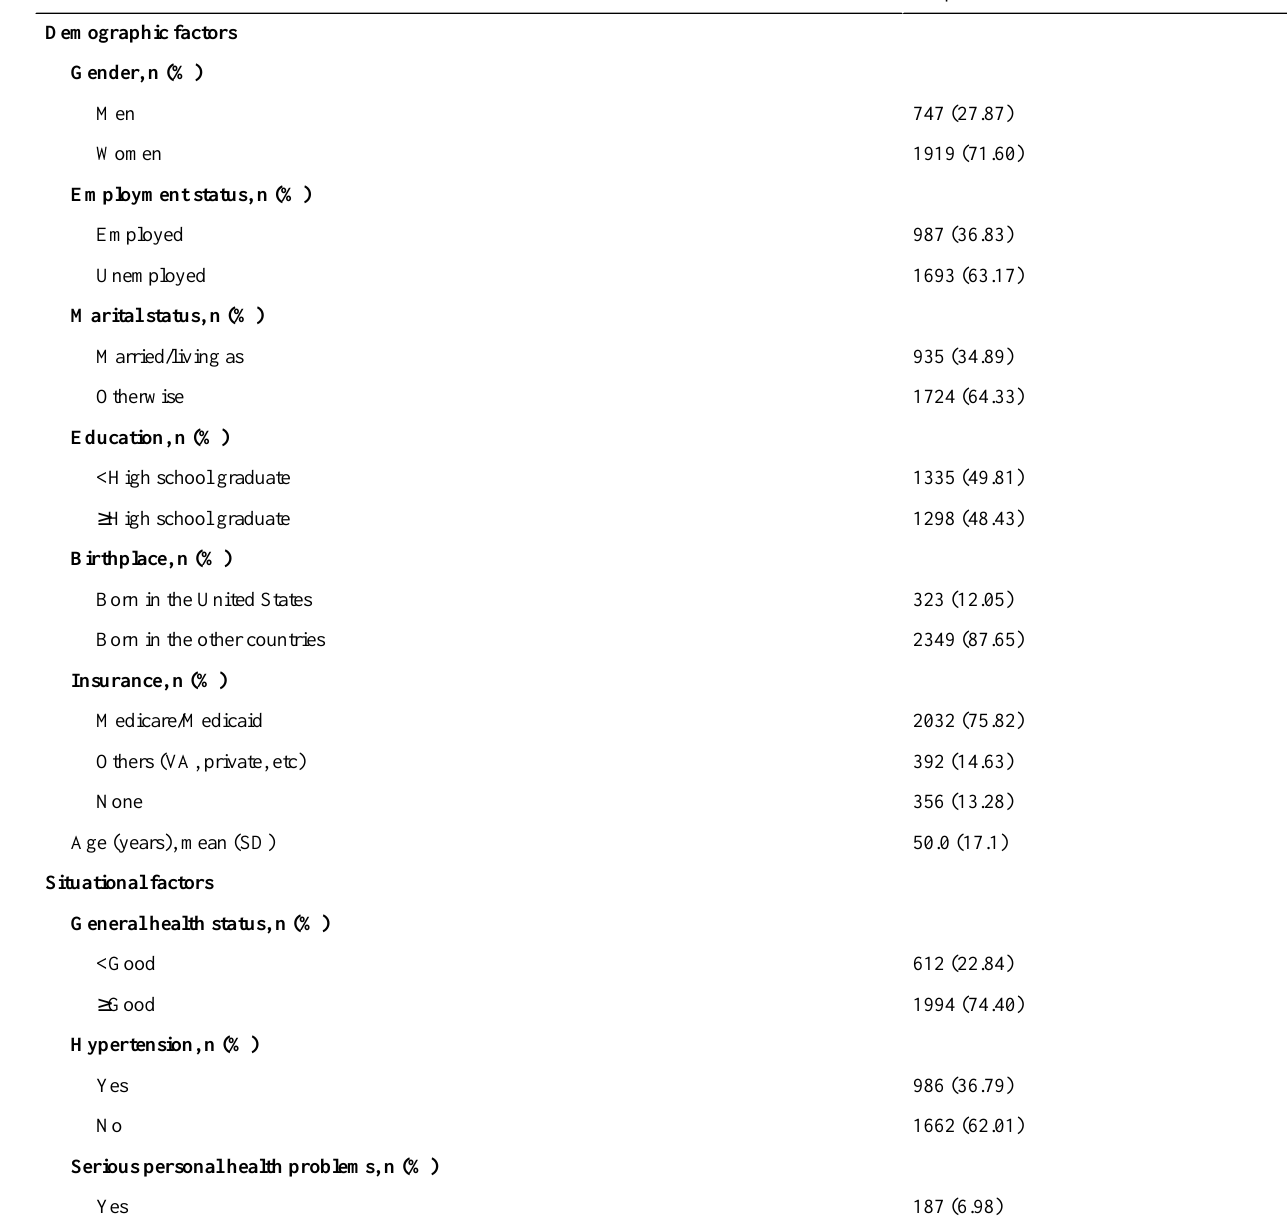
Table 2. Descriptive characteristics of Hispanic participants